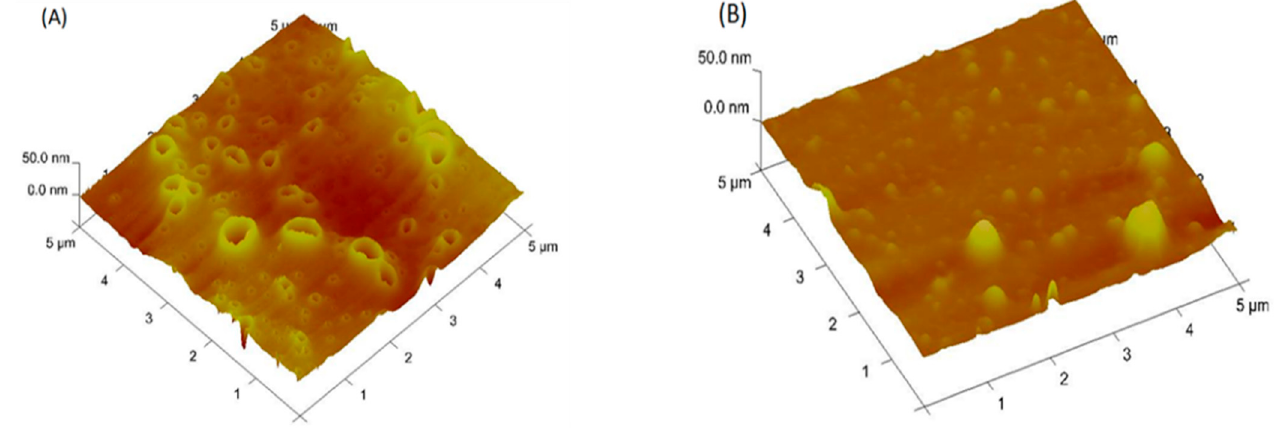
Figure 7. Atomic force microscope (AFM) images of nanocomposites of ( A ) PDMA–PVS and ( B ) glassy carbon electrode (GCE)| PDMA–PVS–Ag 0 .